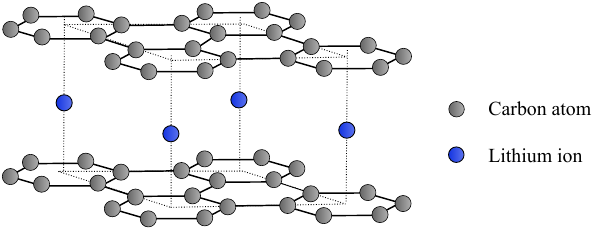
Figure 2. Crystalline structure of lithiated graphite. Lithium ions are depicted in blue and intercalate between the graphene planes. Carbon atoms are depicted in